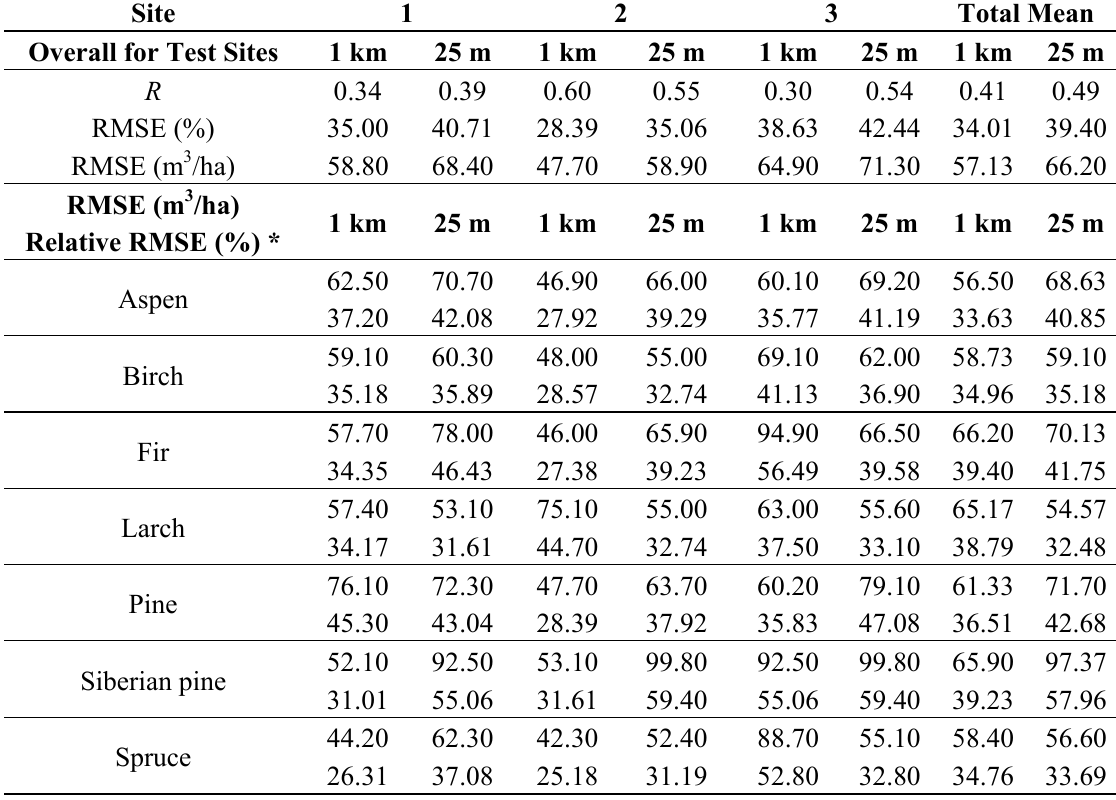
Table 4. Comparison of ENVISAT ASAR (1 km) and ALOS PALSAR (25 m, resampled to 1 km) growing stock volume maps with forest inventory data for Bolshemurtinsk/Kasachinsk (1), Abansk/Dolgomostowsk (2), and Padunsk (3). Correlation coefficients, root mean square errors (RMSE), and relative RMSE are shown for each test site (mean values per test site and total mean); RMSE and relative RMSE are shown for the dominant species (mean values per test site and total